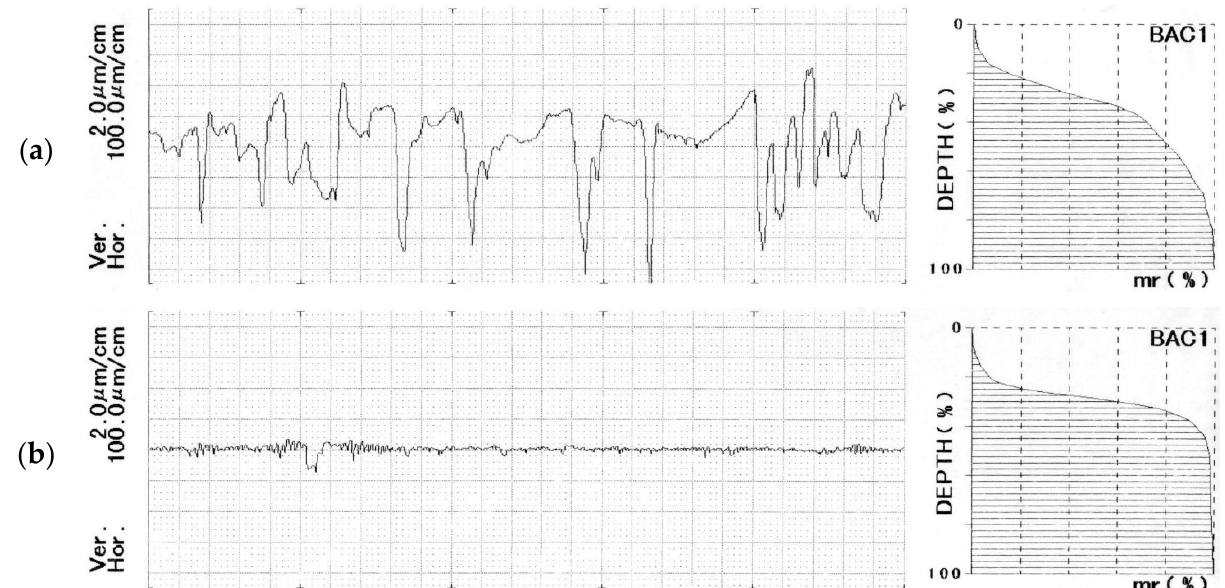
Table 1. Surface roughness parameters for steels DC 05 and AISI 304.